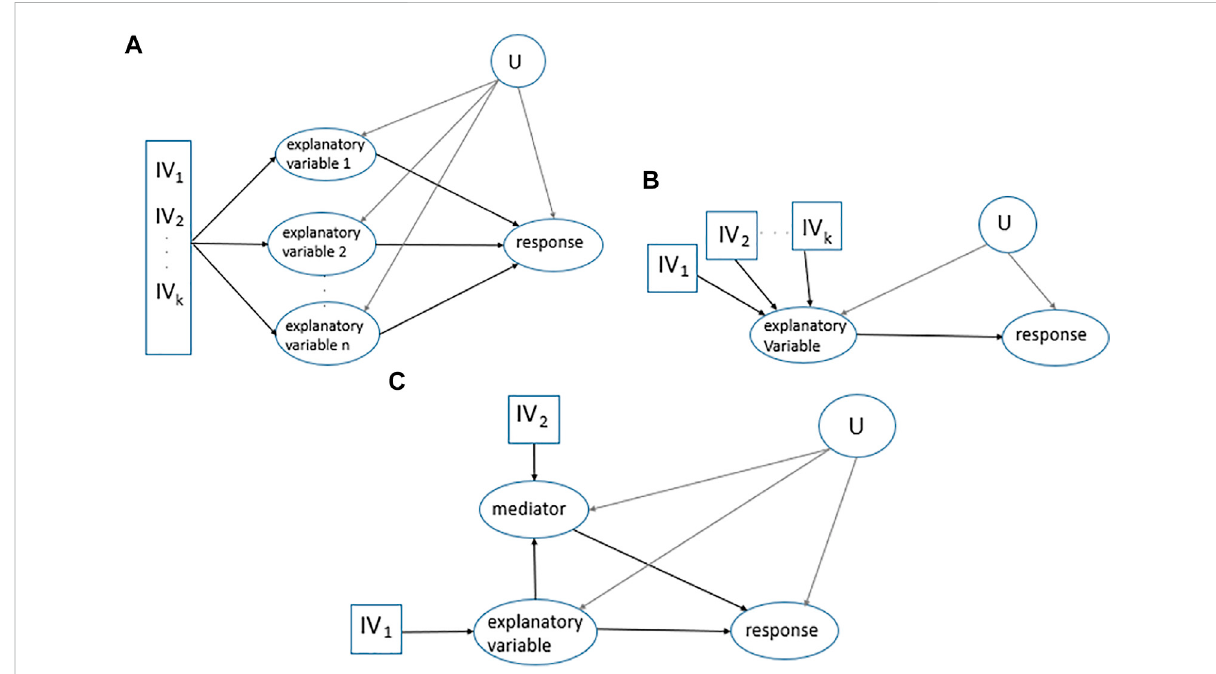
FIGURE 1 MR applications. (A). Multivariable MR. Multiple IVs for multiple explanatory variables of the same response to estimate the direct effect of each explanatory variable on the response. U stands for a set of confounders. (B). Multiple uncorrelated IVs. Multiple uncorrelated IVs for one explanatory variable to predictsigni fi cantvariation in theexplanatory variable, satisfy arobust relationship between theIV and theexplanatoryvariable. (C). Two- step MR for mediation analysis. In the case that there is a mediator, considering two IVs (one for the explanatory variable and one for the mediator) facilitates measuring the direct effect of the explanatory variable X on the